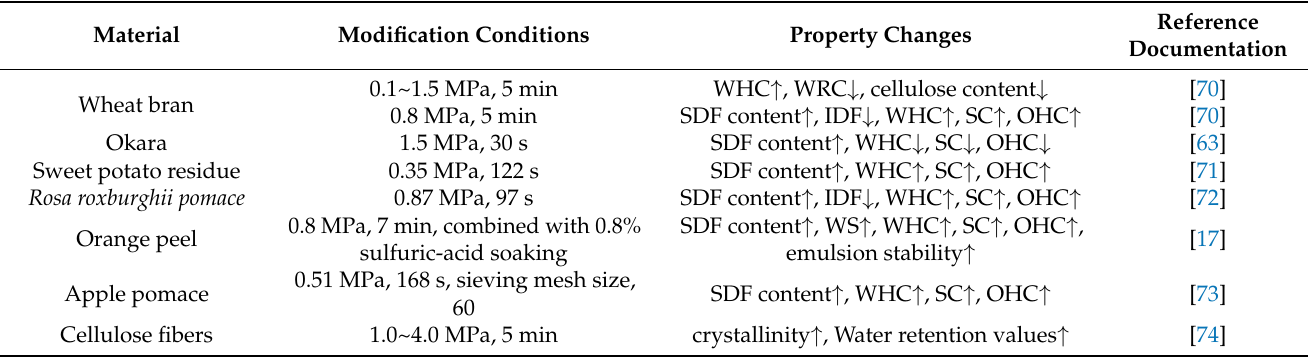
Table 2. Effect of Steam explosion on the physicochemical properties of dietary